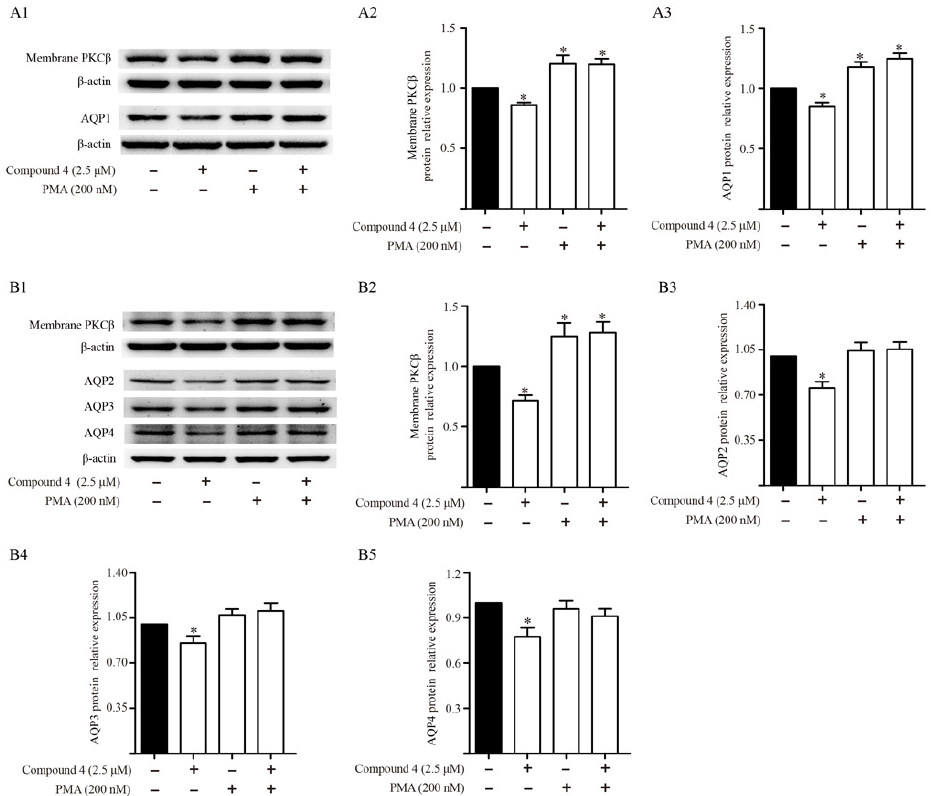
Figure 10. Effects of activator of protein kinase C (PKC) on diterpenoid-induced inhibition of aquaporin (AQP)-1 in human kidney-2 cells (HK-2), and AQP2, AQP3 and AQP4 in murine inner medullary collecting duct cells (mIMCD3). ( A1 – A3 ) Western blot bands and relative protein expression of membrane PKC β and AQP1 in HK-2 cells. ( B1 – B5 ) Western blot bands and relative protein expression of membrane PKC β , AQP2, AQP3 and AQP4 in mIMCD3 cells. The data are represented as the mean ± SD, n = 3, * p < 0.05 vs. control group (Mann–Whitney U test).